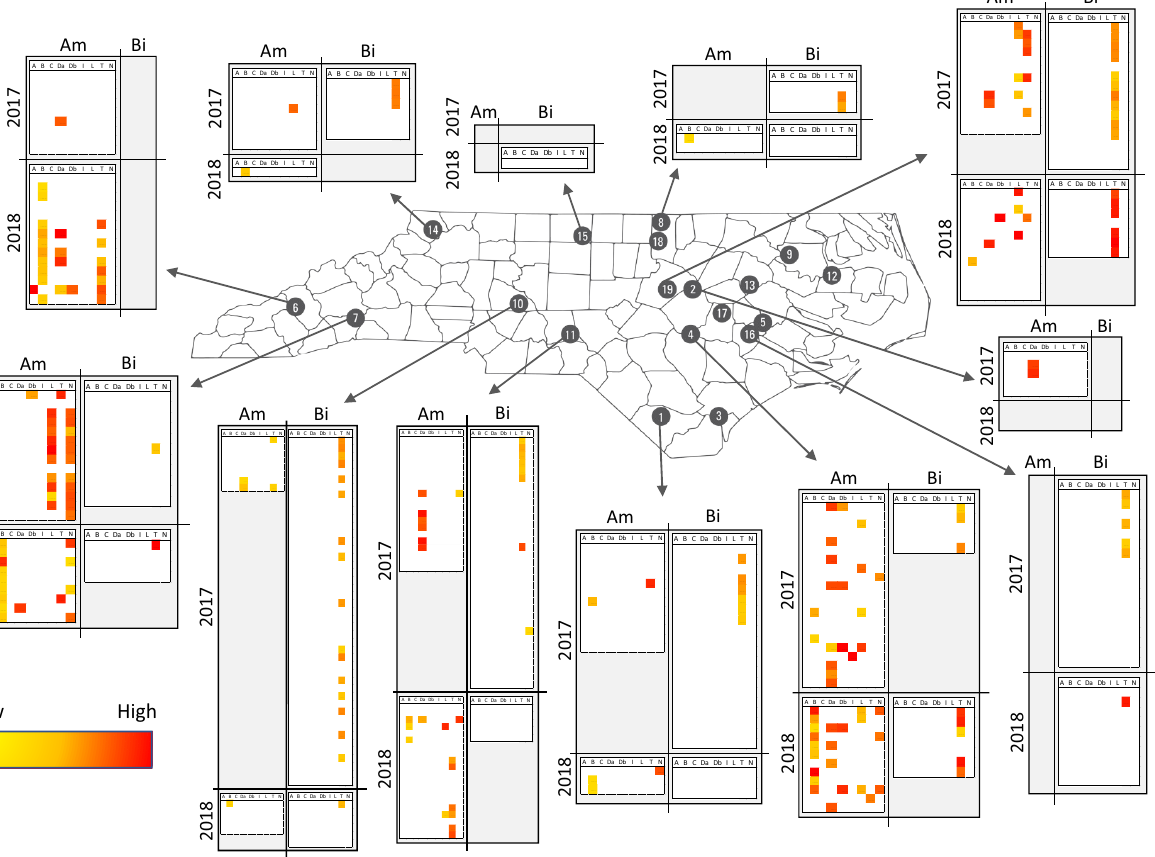
Figure 1. Visual comparison of viral matrices. Each block shows samples from a particular location with A. mellifera (Am) [on the left-hand matrix of each block] and B. impatiens (Bi) [on the right-hand matrix]. Samples from 2017 are displayed at the top of each block and 2018 on the bottom. Each row represents an individual sample, and each column represents a different target listed in alphabetical order (A = ABPV; B = BQCV; C = CBPV; Da = DWVa; Db = DWVb; I = IAPV; L = LSV; T = Try. spp.; and N = Nos. spp.). Relative intensity is represented with a color gradient from low (bright yellow) to high (bright red). This figure was created using Adobe Illustrator, Microsoft Excel, and Microsoft Word. Thank you to Kirsten Benson for creating the base number as dependent variables in a ZINB model. We then used an ANOVA in base R to compare A. mellifera presence and relative intensity to B. impatiens presence and relative intensity . When constructing our ZINB models, year was not found to significantly impact pathogen detection in A. mellifera (all p > 0,34), except for BQCV detections ( p < 0.05). As such, year was only included as a random effect in models when analyzing BQCV detection in A. mellifera . Additionally, sampling location was not found to sig- nificantly impact pathogen detection in A. mellifera (all p > 0.16), except for Nosema spp. detections ( p < 0.0001). However, in order to maintain statistical power, it was not included in any of our models. Both year ( p < 0.0001) and station ( p < 0.005) were found to significantly impact Trypanosome spp. detections in B. impatiens , however through an AIC based approach for best model selection these variables were not included in our final model. Due to low sample size and low pathogen presence, we were not able to conduct further analyses on the patho- gen results from the remaining six bee species; however, these findings are summarized descriptively below. All analyses were conducted in RStudio (version 3.6.2) using base R 72 , the pscl 73 package, and the boot 74 packages.